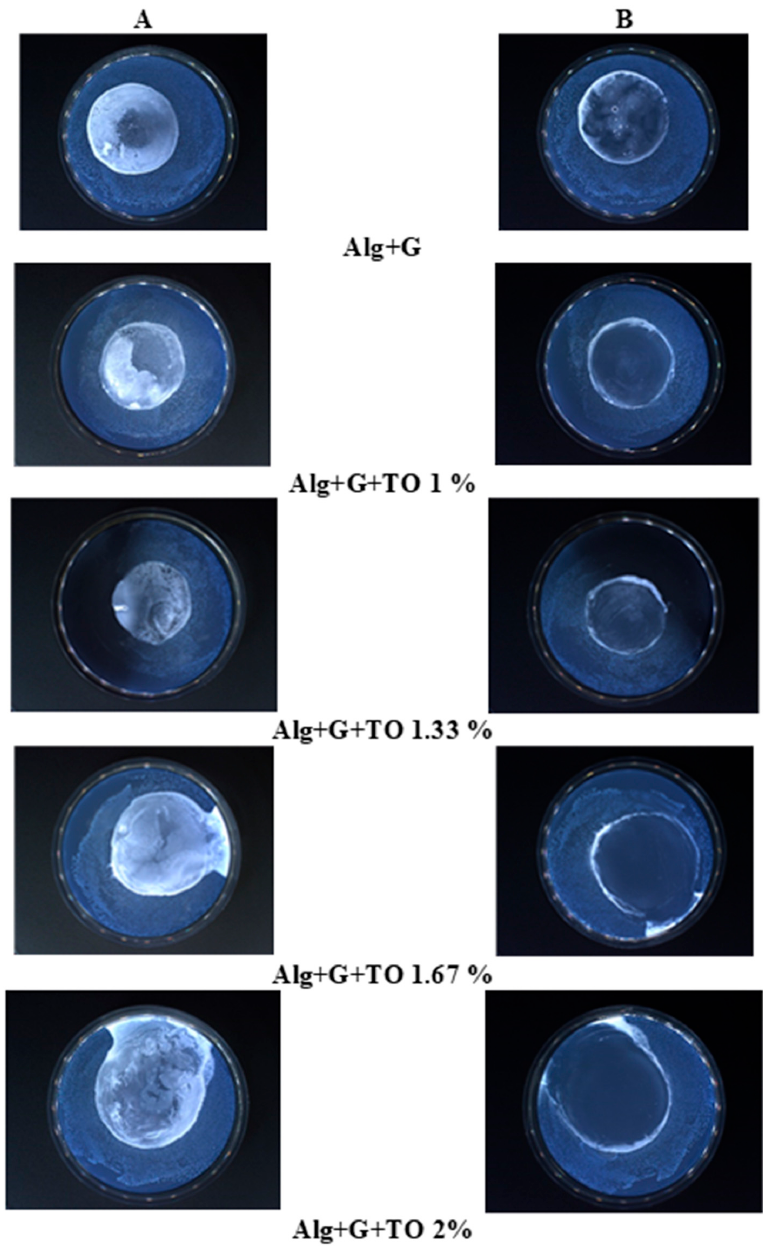
Figure 4. Growth of S. aureus in the area of contact of the sample with the agar (( A )—photos with the tested samples, ( B )—photos after removing the tested